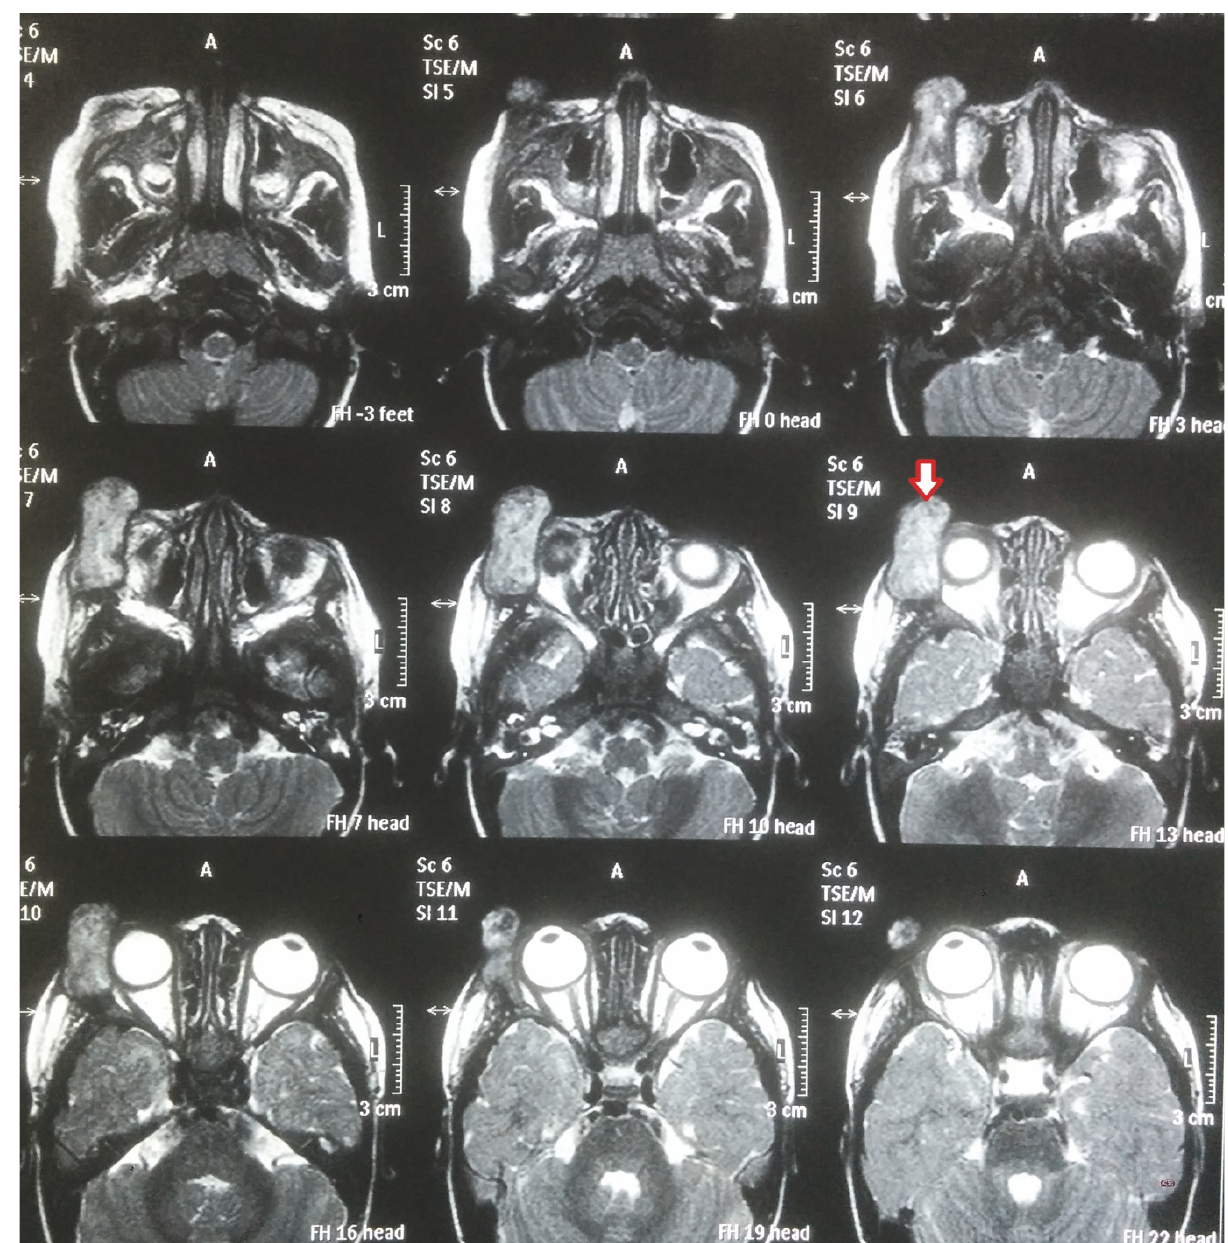
Figure 1: Prechemotherapy MRI scan showing localization and extent of eosinophilic granuloma with bony erosion. Arrow shows the actual pathology, that is, the eosinophilic